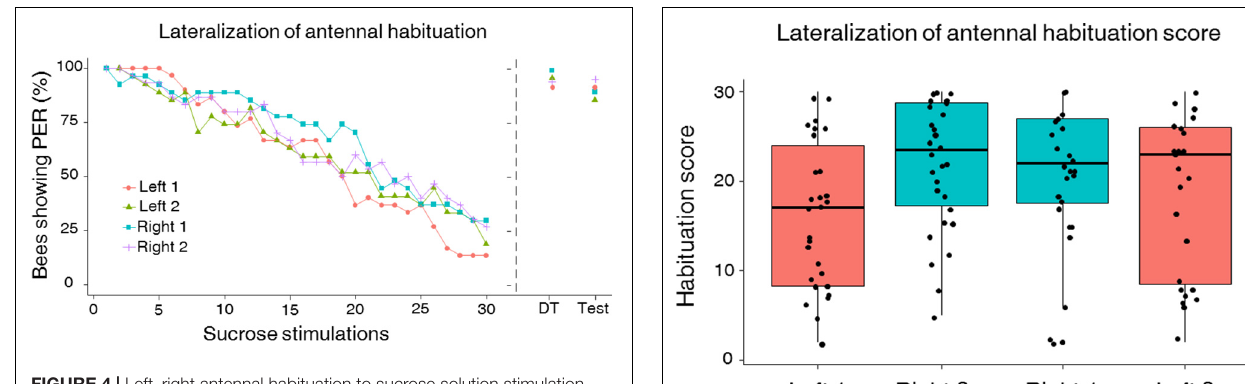
FIGURE 4 | Left–right antennal habituation to sucrose solution stimulation. Like in the sucrose responsiveness assays, approximately half of the bees were first tested for habituation on the right antenna (Right 1) and then on the left antenna (Left 2) ( n = 27) while the other half experienced the reversed sequence (Left 1 and Right 2; n = 30). The two sequences of side stimulation were spaced by 2 h. Habituation consisted in 30 consecutive stimulations with a 10% (w/w) sucrose solution on the free antenna (while the other one was blocked). Ten seconds after the last habituation trial, bees were stimulated on the habituated antenna with a 50% (w/w) sucrose stimulation to induce dishabituation (“dishabituation trial” or DT). Ten seconds after the DT, bees were stimulated on the same antenna with the original stimulus used during the training (i.e., 10% sucrose solution) to check for typical response recovery following dishabituation (“Test”). The right antenna was more resistant to habituation than the left one at the population level (GLMM, p = 0.006). Habituation to sucrose stimulation was significantly affected by the SRS of individual bees (GLMM, p < 0.0001), thus demonstrating that the left–right antennal asymmetry in sucrose sensitivity translates directly into a lateralization of habituation to sucrose stimulation. The order of testing had no effect on habituation. No significant left–right differences in the DT as well as in the test were observed (Wilcoxon test, DT: p = 0.41, test: p = 0.36). The DT as well as re-stimulating with the original stimulus induced a significant response recovery, which did not differ between sides. This demonstrates that the observed decrease in PER to the 10% sucrose solution was a real case of habituation and was not due to sensory adaptation or fatigue.